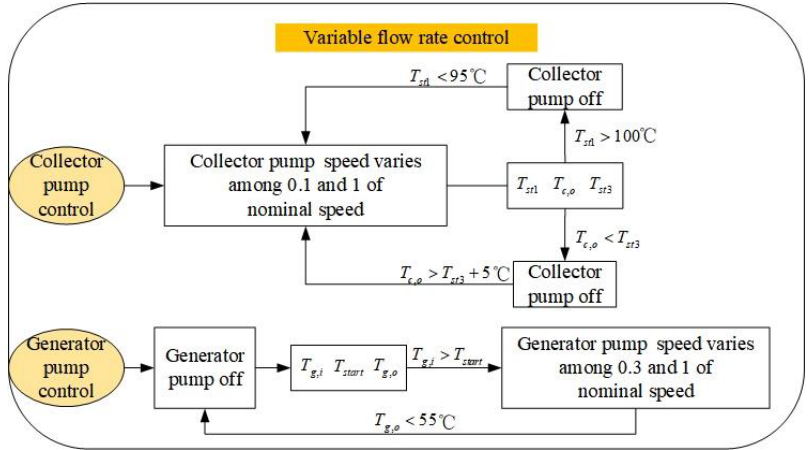
Figure 2. Control strategies for collector and generator pumps.